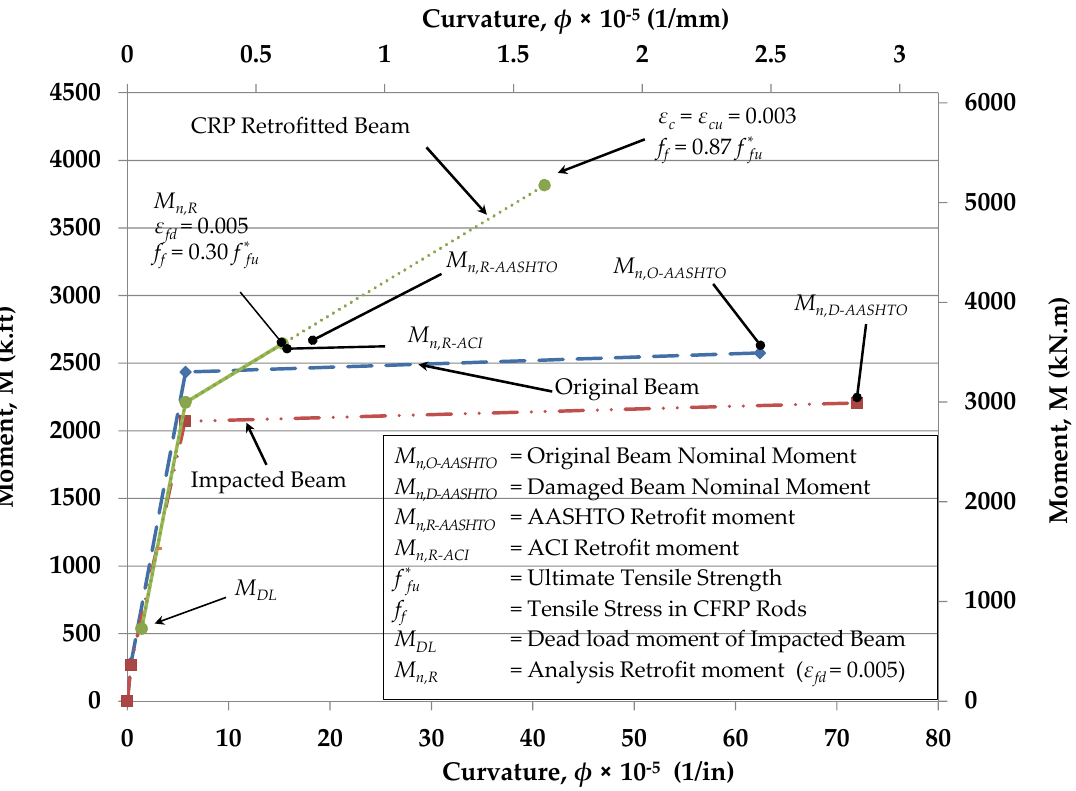
Figure 8. Moment ‐ Curvature response of undamaged, damaged and retrofitted cross ‐ sections. Figure 8. Moment-Curvature response of undamaged, damaged and retrofitted